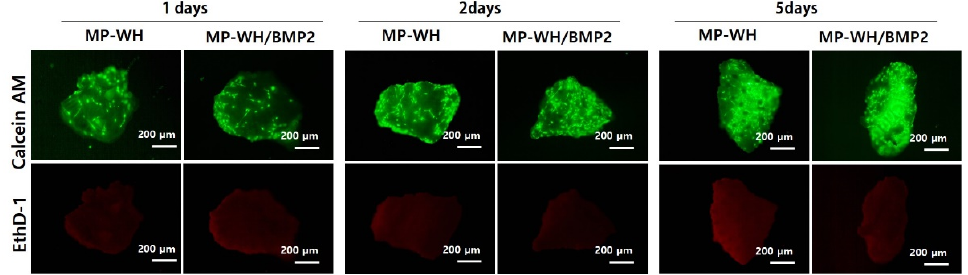
Figure 6. Cytotoxicity of MP-WH and MP-WH/BMP2 granules. The cell viability/cytotoxicity of MSCs is determined using live/dead fluorescence staining with Calcein AM and EthD-1 after 1, 2, and 5 days of cultivation. Calcein-AM stained healthy live cells are shown in green, while EthD-1 stained dead and unhealthy cells are shown in